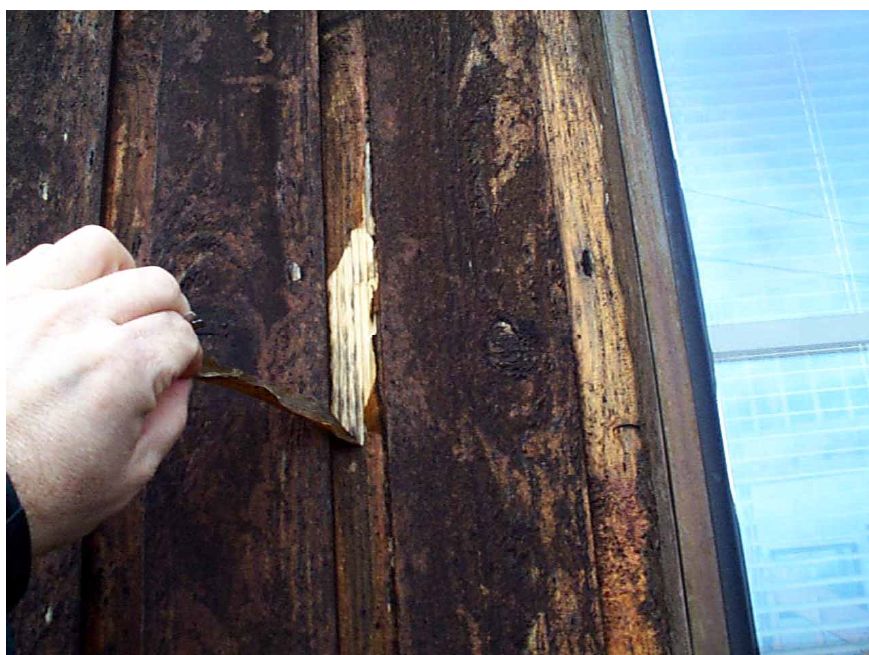
Figure 5. Example of a delaminated clear polymeric coating on wood being peeled from the surface after three years of exposure in a damp exterior environment. In this example, the finish was originally clear, similar to that seen in Figure 4. Fungi were involved in darkening of the finish and also, once they penetrated the coating film, in the delamination of the coating from the wood surface. In this example, the manufacturer’s use of iron in the coating formulation also promoted the extreme darkening of the coating as, in this wet environment, wood extractives were driven to the surface, and these extractives reacted with the iron in the coating to produce the intense dark coloration (Goodell photo).